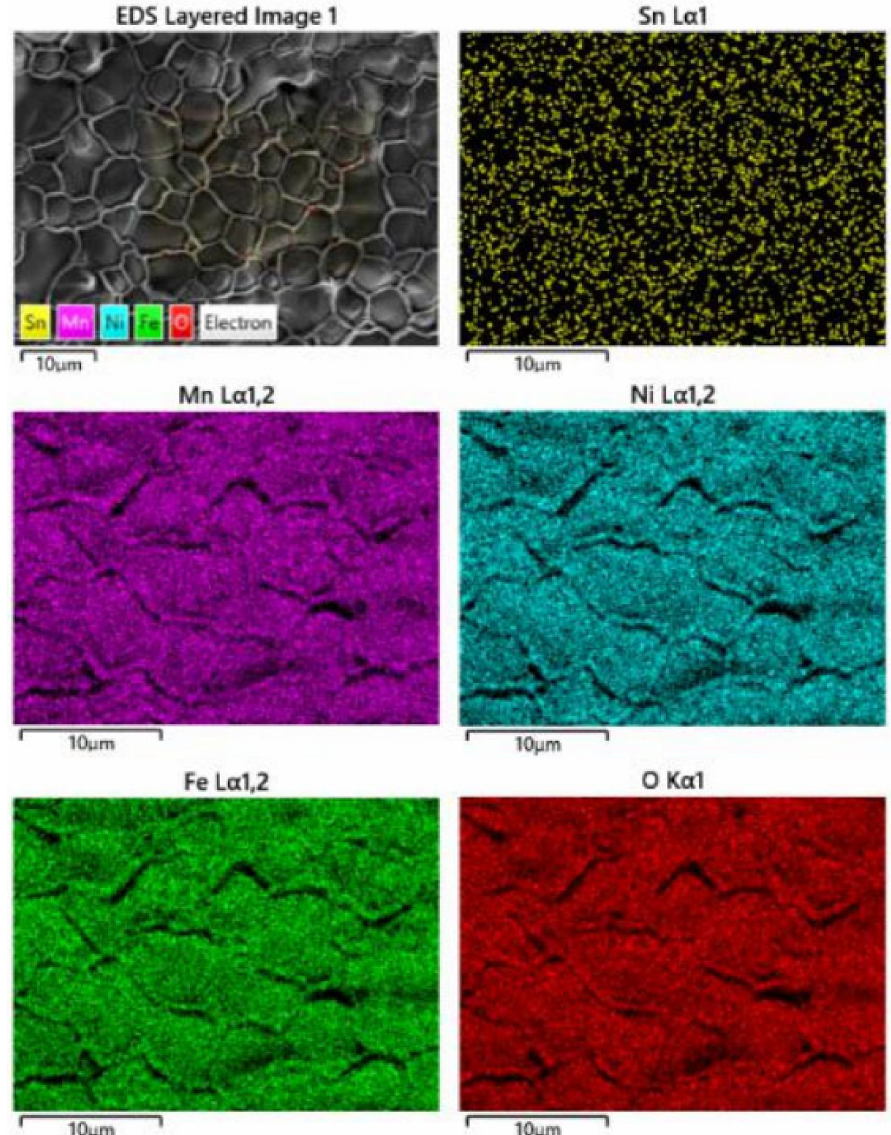
Figure 8. The EDS element maps of the sintered S4 sample